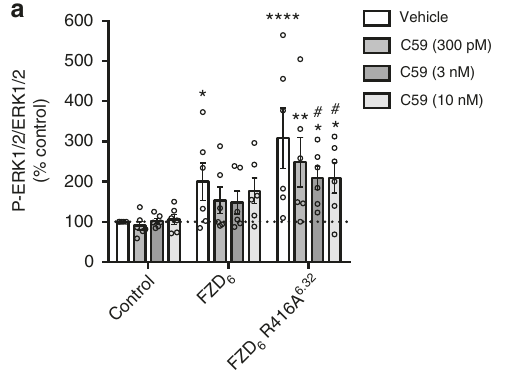
Fig. 3 Mutation of R 6.32 in FZD 6 affects basal receptor activity. FZD 6 - and FZD 6 R416A 6.32 -induced ERK1/2 phosphorylation in the absence and presence of the Porcupine inhibitor C59 (300 pM, 3 nM, 10 nM) in HEK293 cells stably expressing the receptors. P-ERK1/2 and total ERK1/2 levels were quanti fi ed by multiplex AlphaScreen. Data are presented as mean ± standard error of the mean (s.e.m.). n = 6; P = 0.0002, F (23, 119) = 2.718. * P < 0.05, ** P < 0.01, **** P < 0.0001 represent comparisons of receptor- mediated P-ERK1/2/ERK1/2 levels with vehicle-treated control cells. # P < 0.05 represents the comparison of P-ERK1/2/ERK1/2 levels in C59-treated cells with vehicle-treated cells (one-way